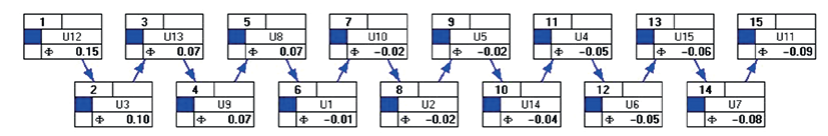
Fig. 4. PROMETHEE II complete